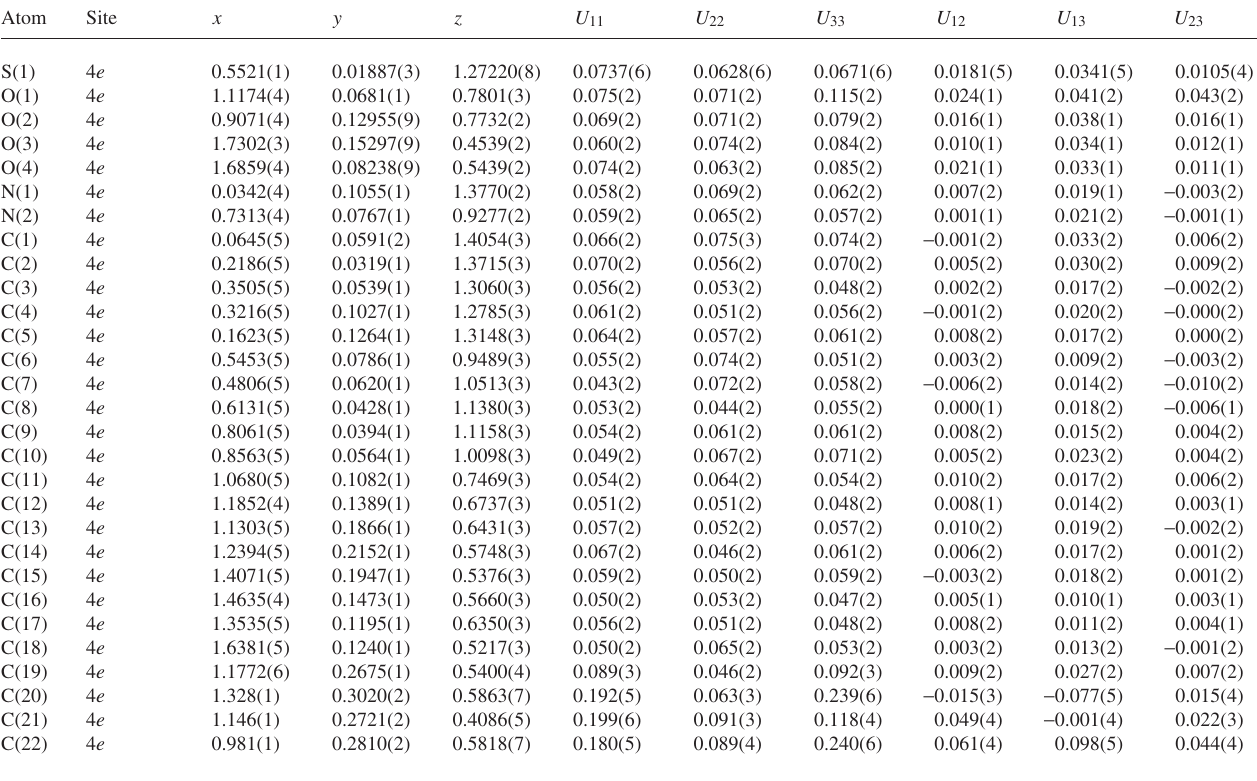
Table 3. Atomic coordinates and displacement parameters (in Å 2 )